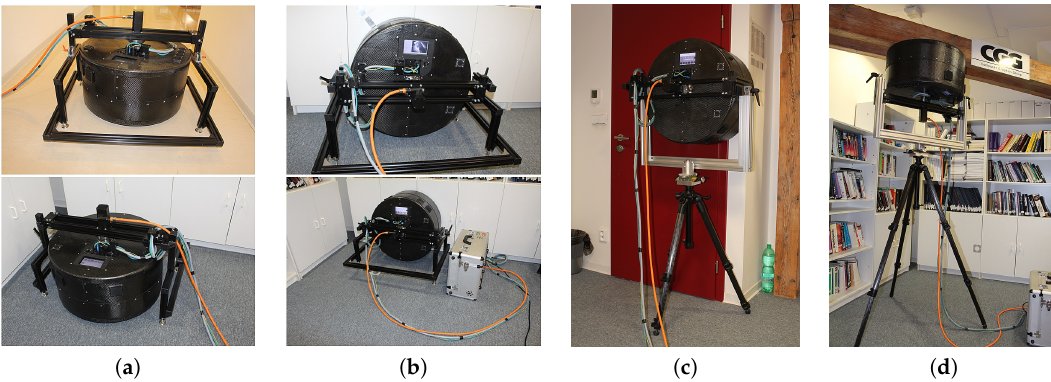
Figure 4. Instrument positioning: ( a ) on a desk/floor; ( b ) for measurement of a vertical wall near the floor; ( c ) for measurement of a vertical wall using a tripod; ( d ) for measurement of a ceiling using a